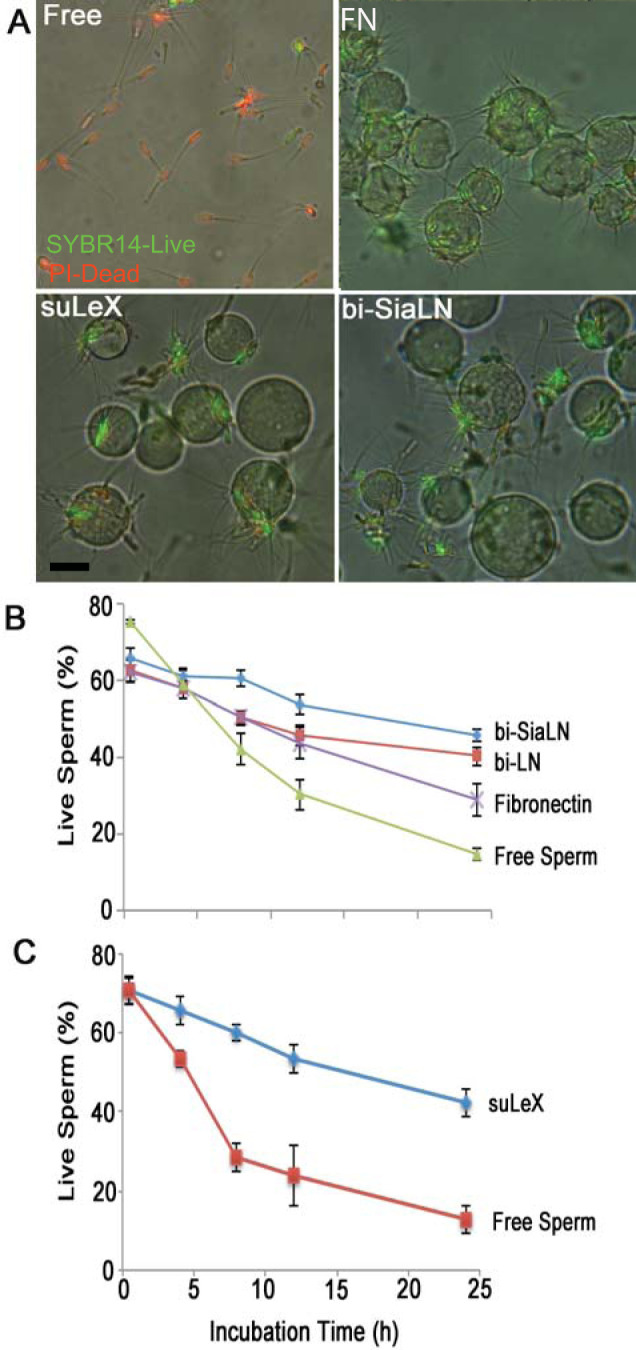
Sperm binding to immobilized bi-SiaLN and suLeX glycans lengthens lifespan.Sperm were incubated with biantennary 6-sialylated N-acetyllactosamine oligosaccharide (bi-SiaLN), biantennary N-acetyllactosamine terminating oligosaccharide (bi-LN), 3-O-sulfated Lewis X trisaccharide (suLeX), 3-O-sulfated Lewis A trisaccharide (suLeA), or fibronectin (FN) coupled to beads. Free-swimming sperm were used as controls. A) Representative photos of sperm stained with SYBR14 (green, live) and propidium iodide (red, dead) after 8 hr of incubation showing free-swimming sperm in medium, sperm bound to suLeX, bi-SiaLN, or fibronectin (FN) coupled to beads. Scale bar in lower left panel indicates 20 μm. B) Enumeration of the percentage of live (SYBR14+, propidium iodide-) free-swimming sperm or sperm bound to bi-SiaLN, bi-LN, or FN on beads. C) Sperm incubated with suLeX coupled to beads. Sperm that were bound to biantennary glycans with or without sialic acid residues on N-acetyllactosamine or bound to suLeX maintained higher viability than free-swimming sperm and sperm bound to FN-coated beads. The asterisks represent significant differences from free-swimming sperm (P < 0.05). These results are means and SEM from 3–5 experiments.